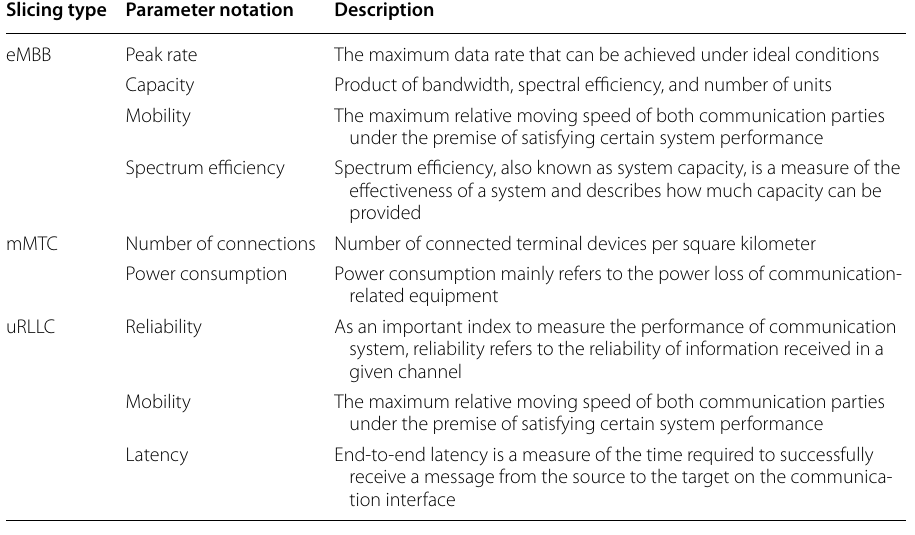
Table 1 Network slicing SLA parameters Slicing type Parameter notation